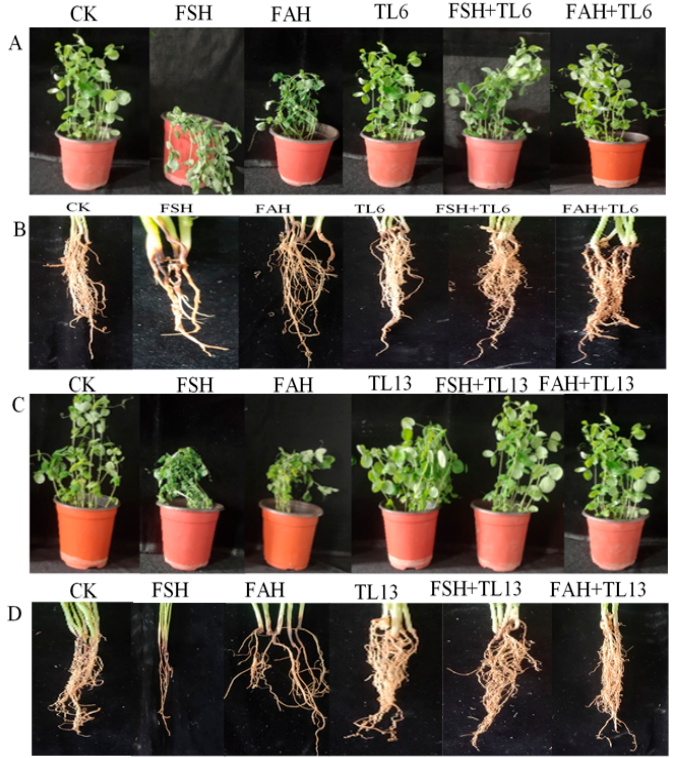
Figure 6. Effects of T. longibrachiatum (TL6 and TL3) on snow pea seedling disease index at 21 days after pretreatment. Panels ( A , C ) stems and leaves; and ( B , D ) roots, showing incidence of disease on snow pea plants after treatment.